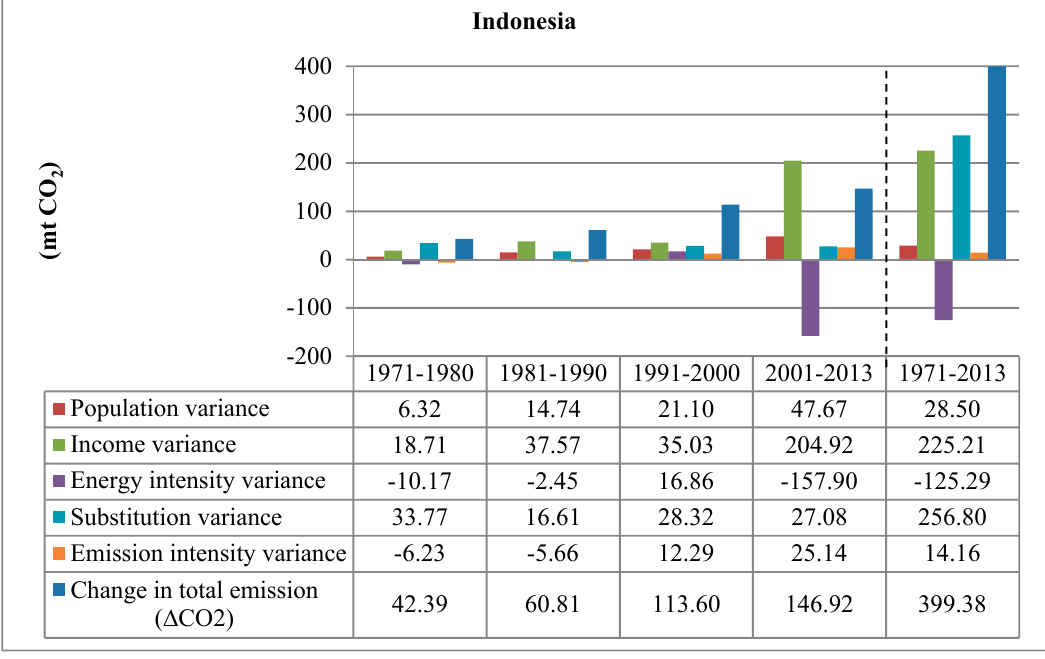
Figure 10. Decomposition results of CO 2 emissions in Indonesia.